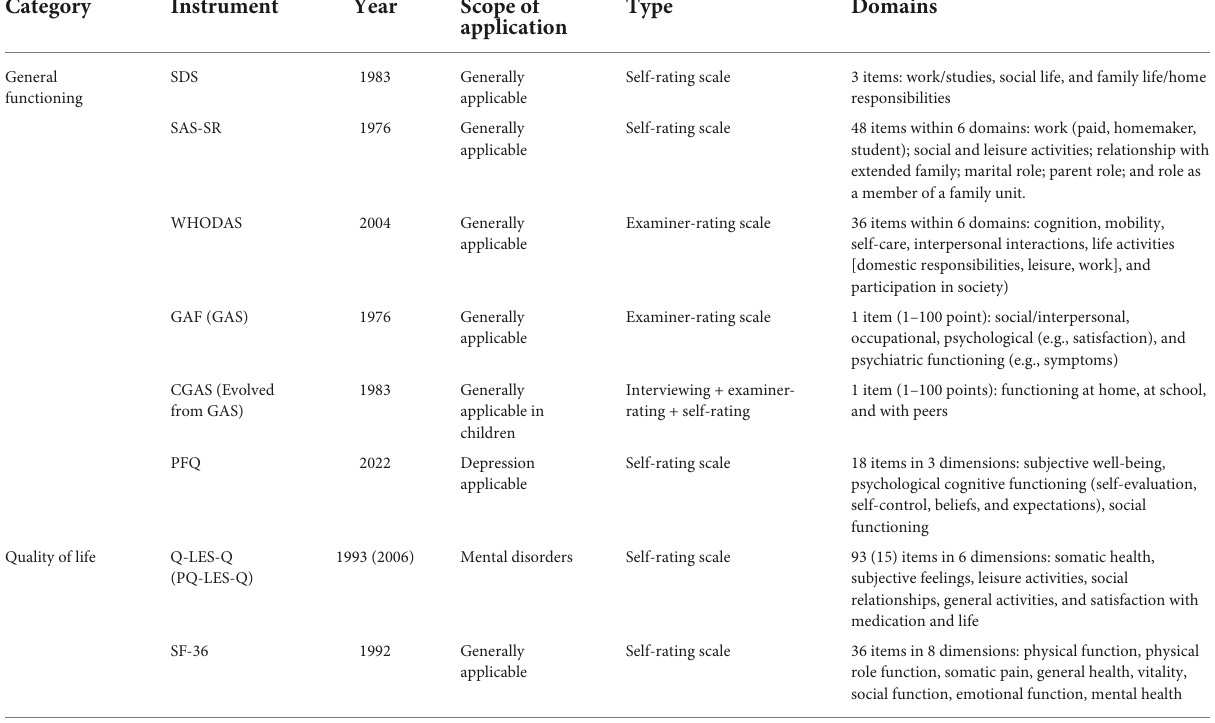
TABLE 4 The main proxy tools for assessing psychosocial functioning in adolescents, adults, and older adults with depression.